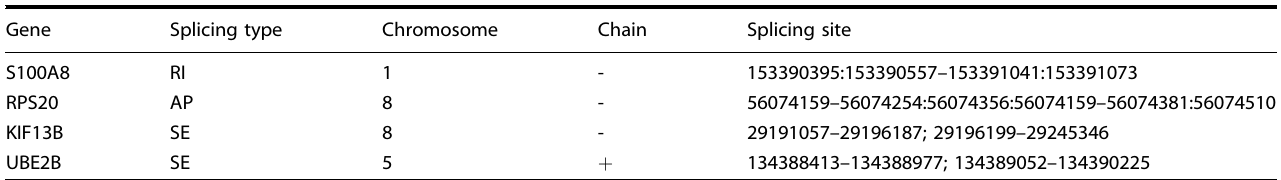
Table 1. The detailed information of selected 4 alternative splicing events